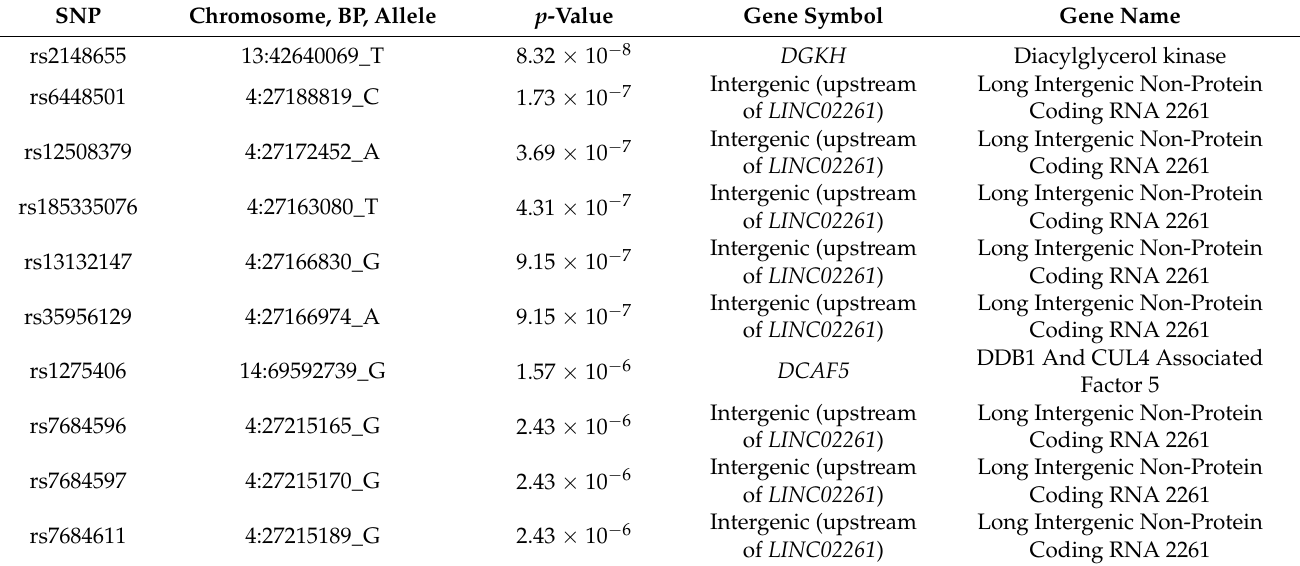
Table 2. Top 10 of NPY-LA associated SNPs in 546 children with T1D at clinical onset (1–3 months